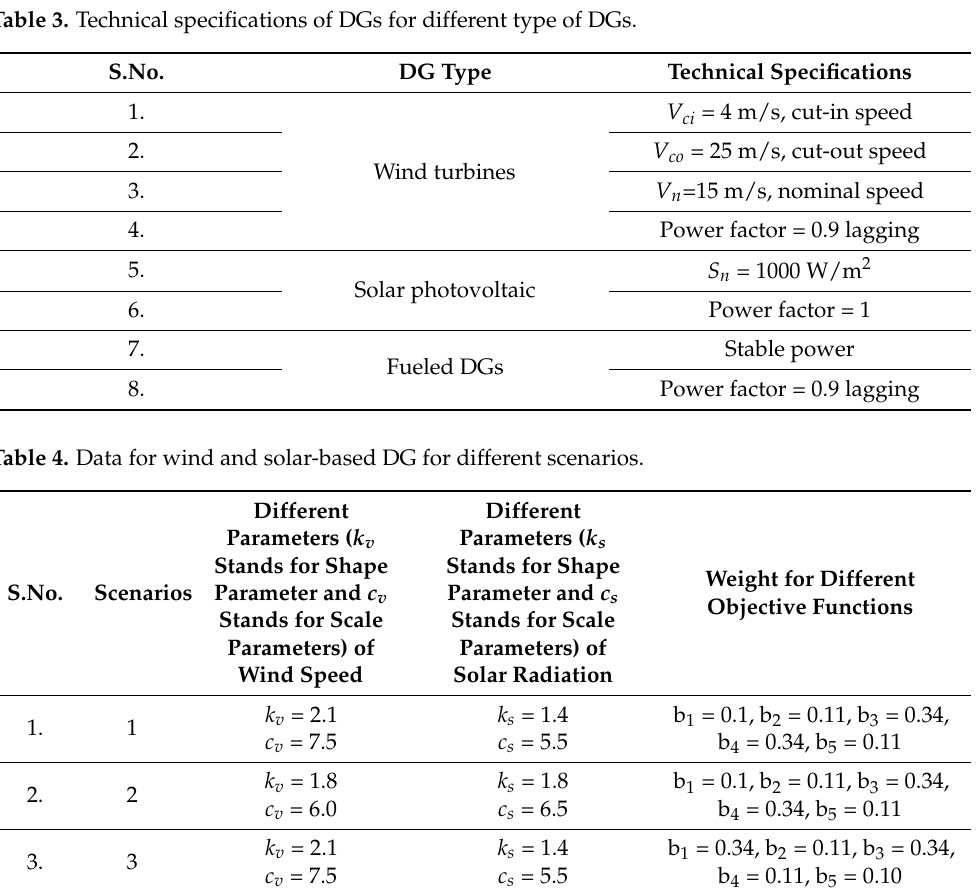
Table 3. Technical specifications of DGs for different type of DGs. S.No.